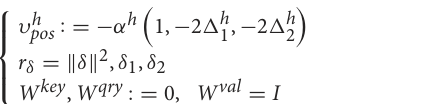
attention head. Trainable embedding υ h pos and relative position coding r ij are added to discipline position information.